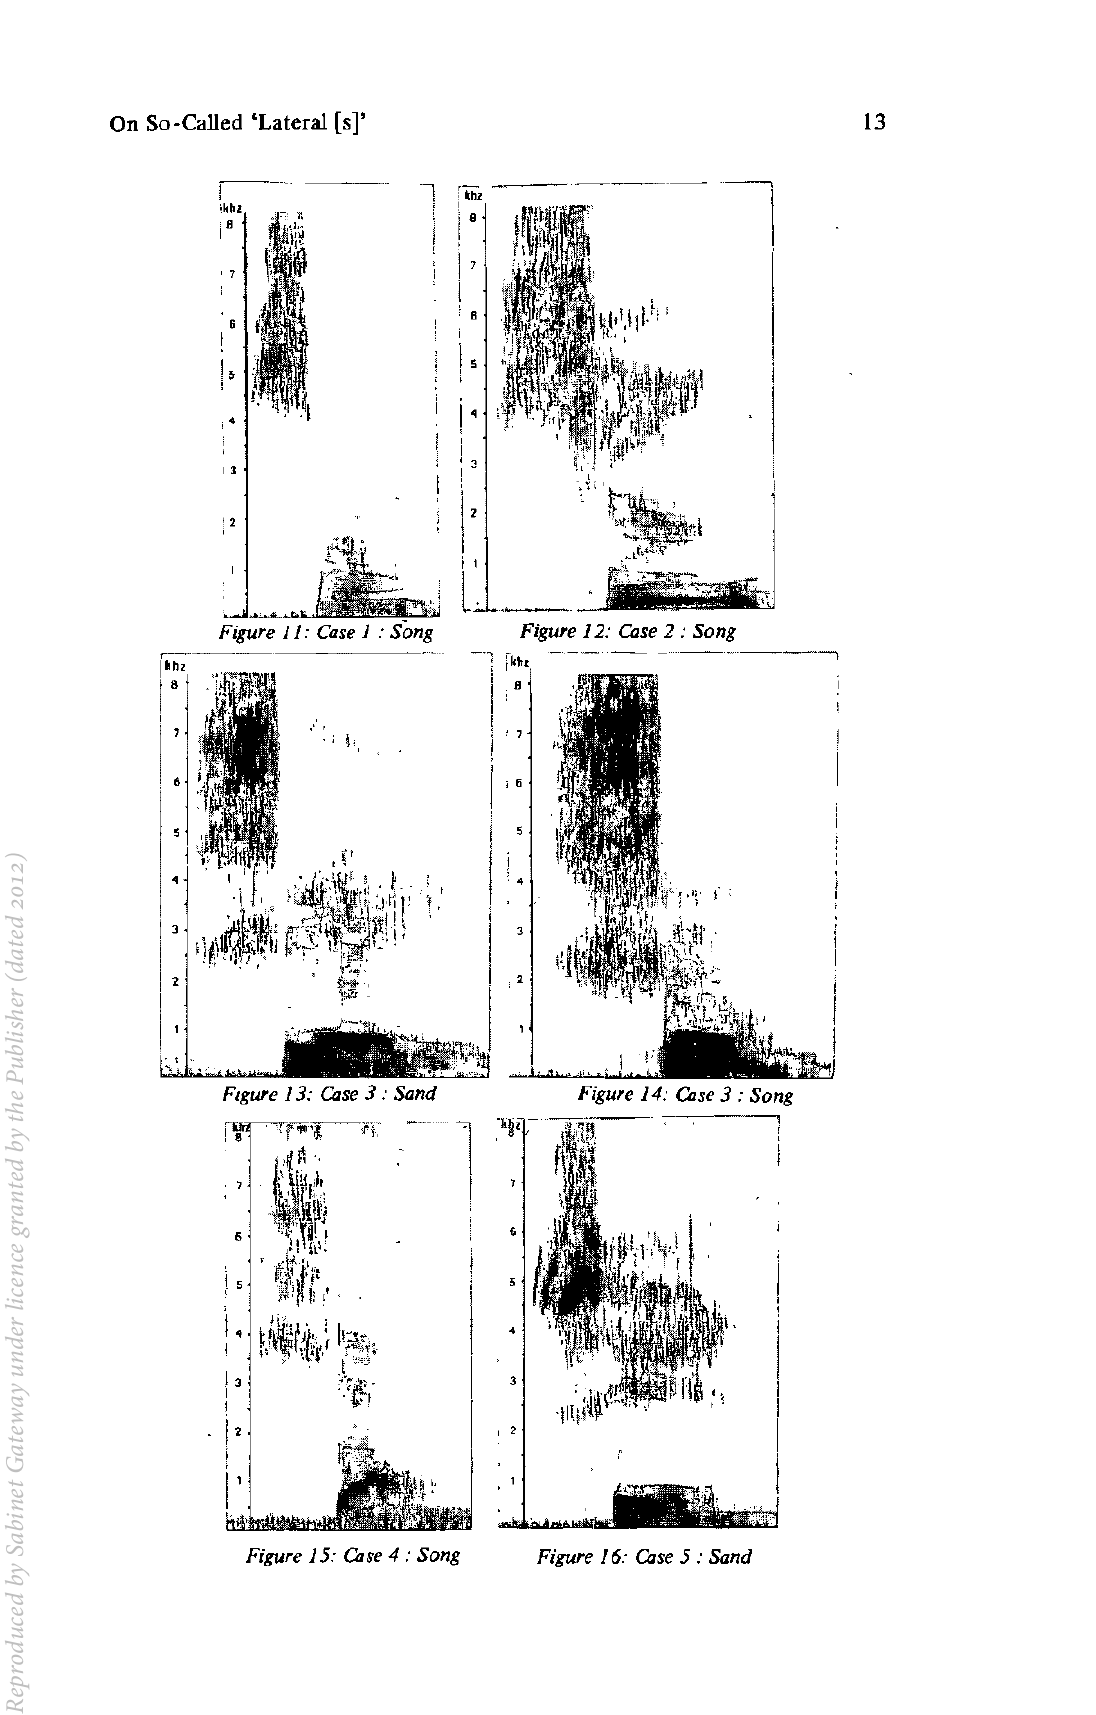
Figure 13: Case 3 : Sand Figure 14: Case 3 :